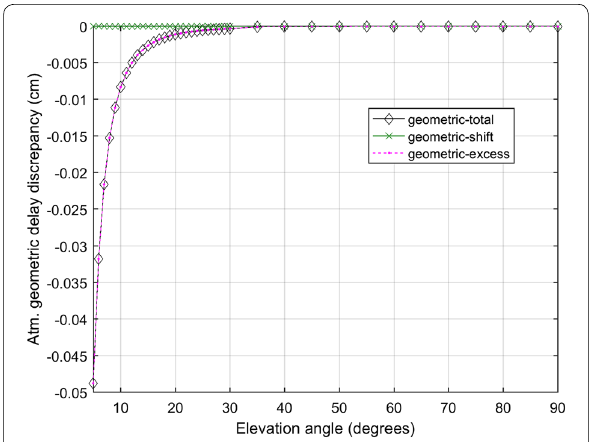
Fig. 6 Discrepancy in interferometric atmospheric geometric delay between RM and RI formulations as a function of satellite elevation angle (for a fixed 10‑m reflector height)